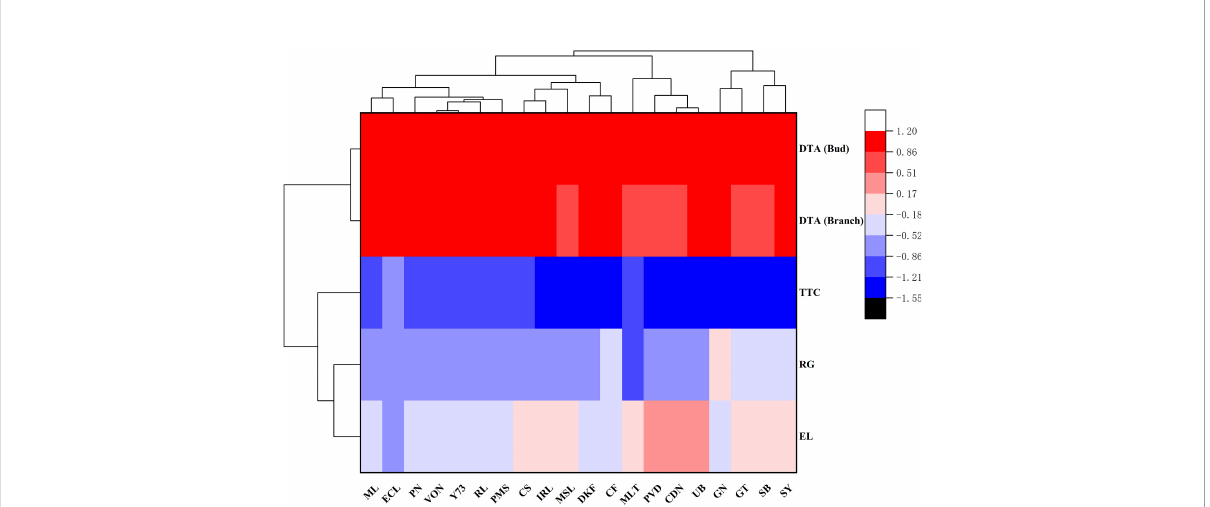
FIGURE 1 Clustering of LT 50 values of V. vinifera varieties subjected to different evaluation methods. Note: The results (LT 50 values) of different evaluation methods were quanti fi ed by the software SPSS17.0. ML (Meili), ECL (Ecolly), GN (Granoir), CS (Cabernet Sauvignon), MSL (Marselan), DKF (Dunkelfelder), PN (Pinot Noir), MLT (Merlot), VON (Viognier), PVD (Petit Verdot), PMS (Petit Manseng), CDN (Chardonnay), SB (Sauvignon Blanc), IRL (Italian Riesling), CF (Cabernet Franc), RL (Riesling), Y73 (YAN73), SY (Syrah), GT (Gewurztraminer), UB (Ugni